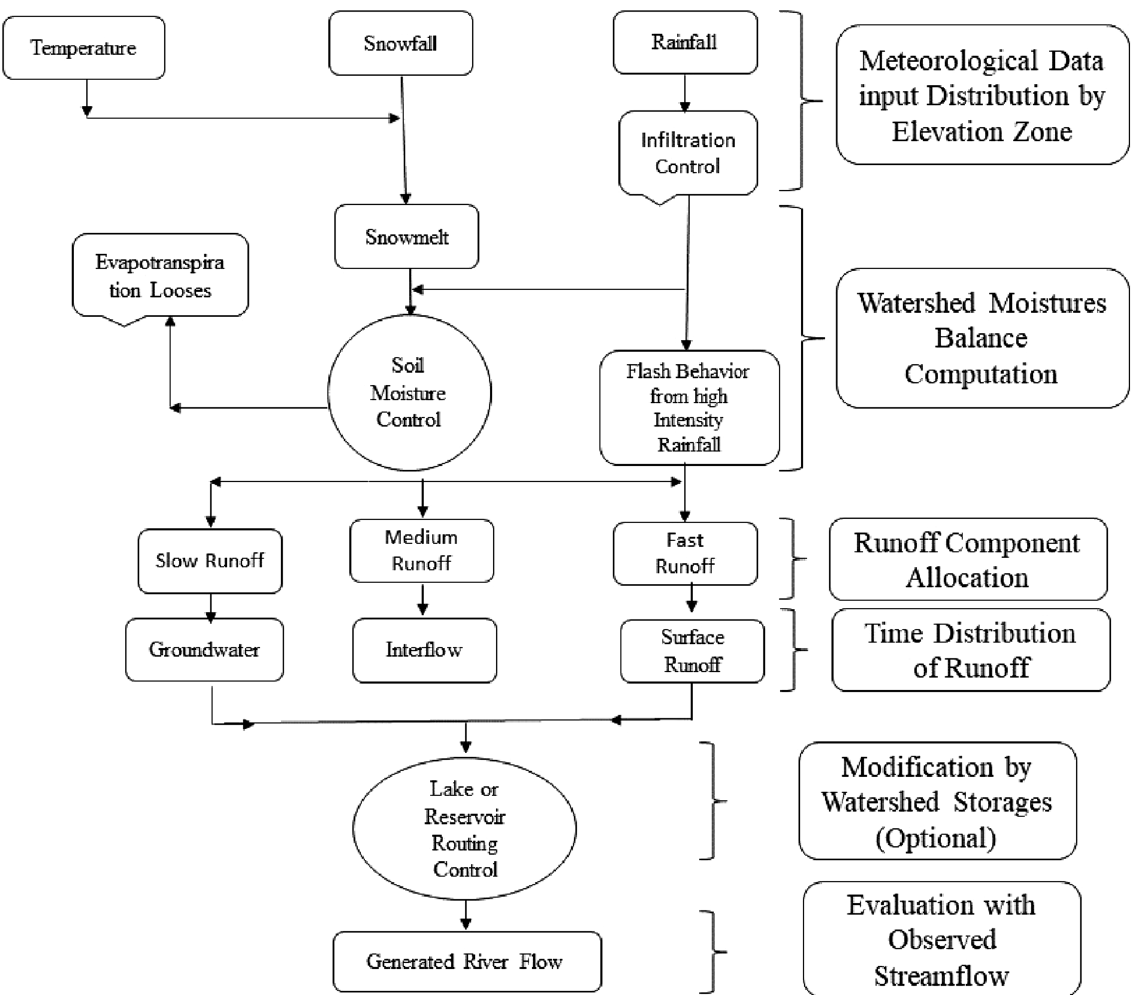
Figure 3. Schematic detail of the University British Columbia Watershed Model